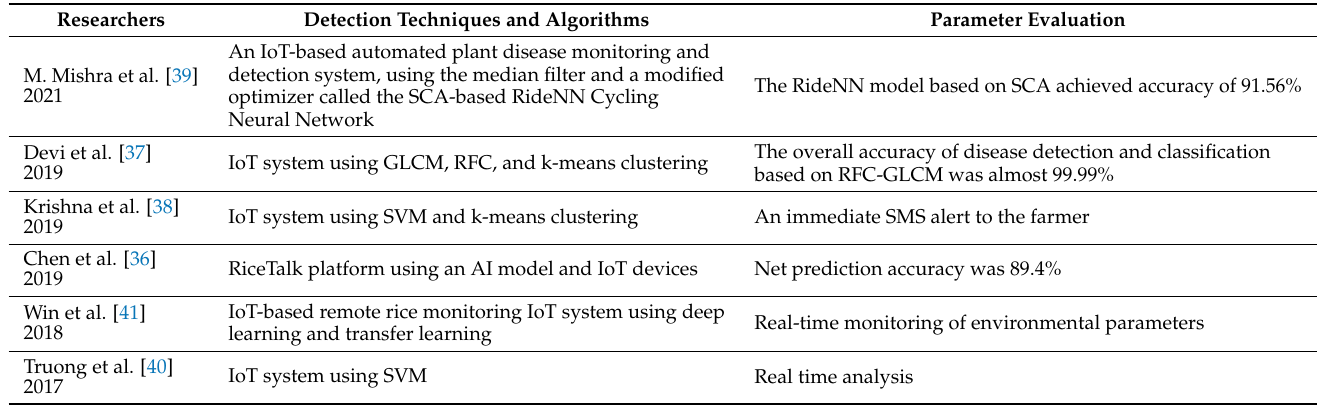
Table 3. Summary of the literature survey on Internet of Things